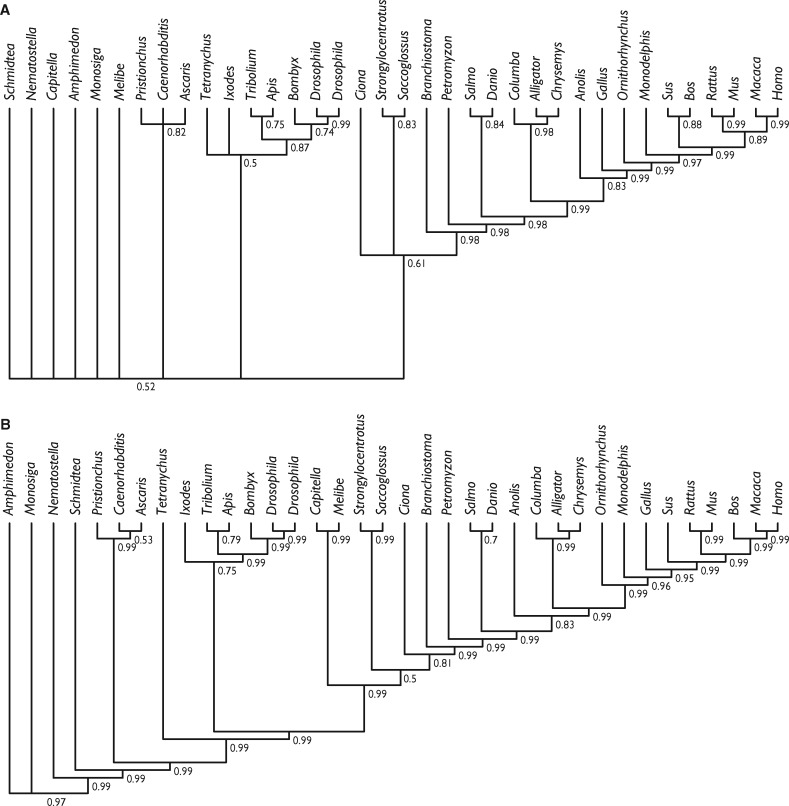
—Phylogenetic tree derived from the Dollo analysis of presence/absence of microRNA families in our uncurated miRBase data set. (A) Shows results whereby all miRNAs were included and (B) where singletons (synapomorphic) miRNAs were excluded. Node values are clade posterior probabilities.